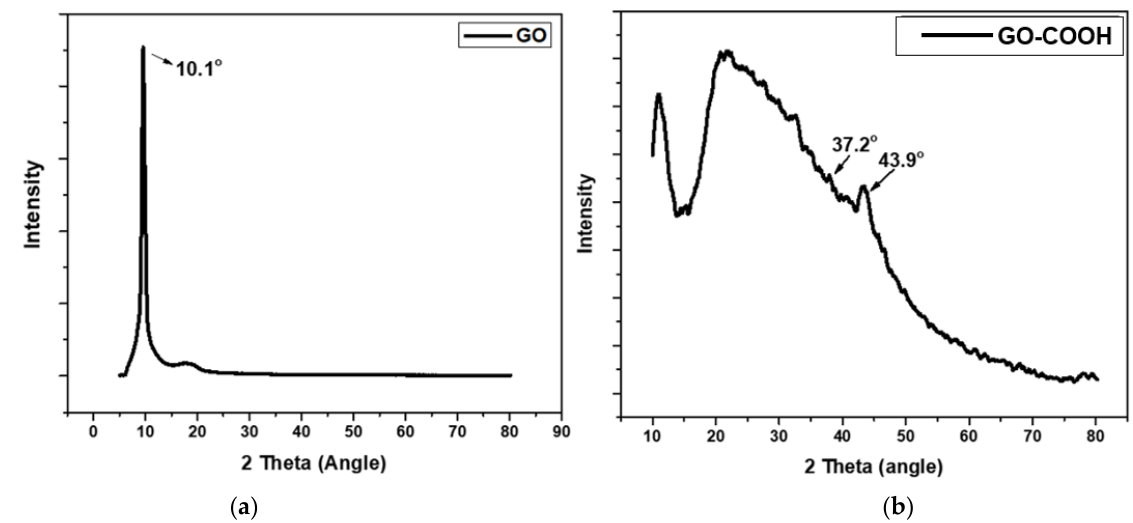
Figure 4. XRD analysis of GO ( a ) and GO-COOH ( b